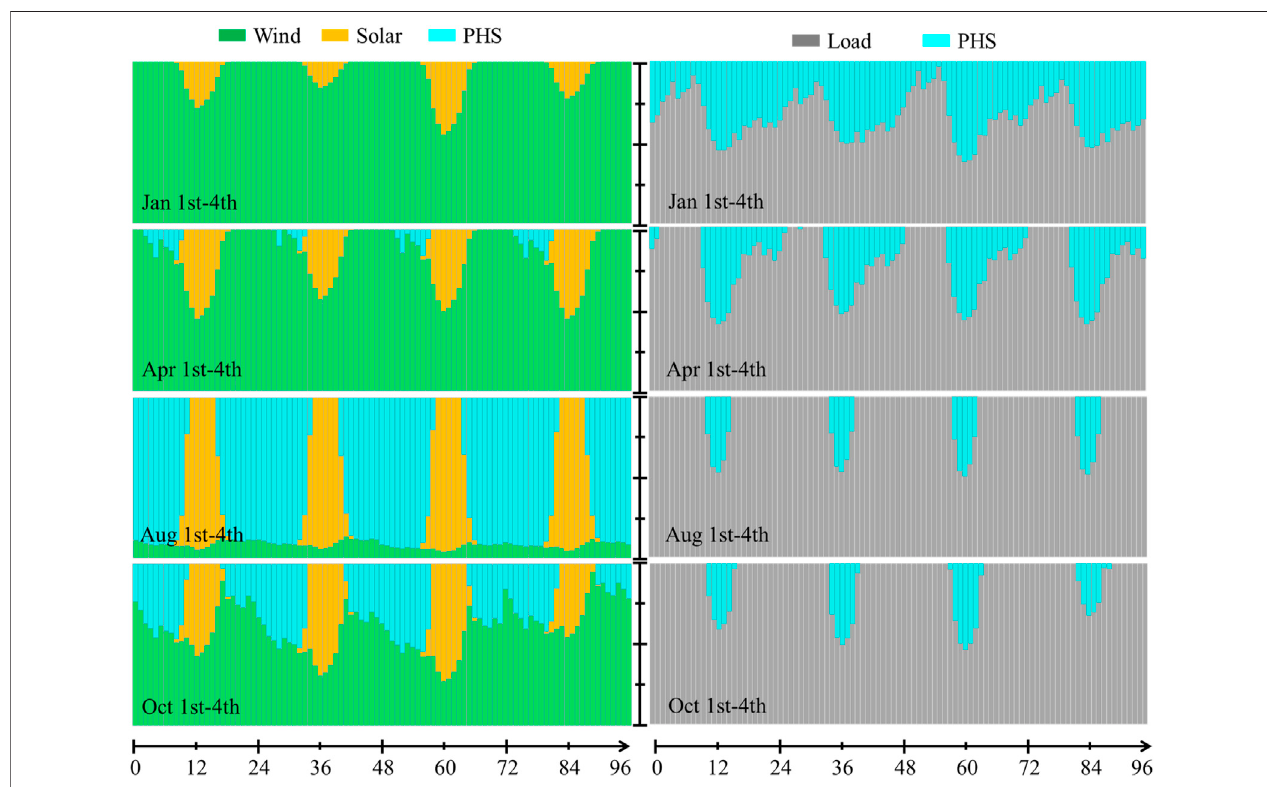
FIGURE 10 | Share of component supply and consumption of the goaf-PHS system during the selected day (January 1 st – 4 th for winter, April 1 st – 4 th for spring, August 1 st – 4 th for summer, and October 1 st – 4 th for autumn). (A) Share of component energy supply; (B) share of component energy consumption.